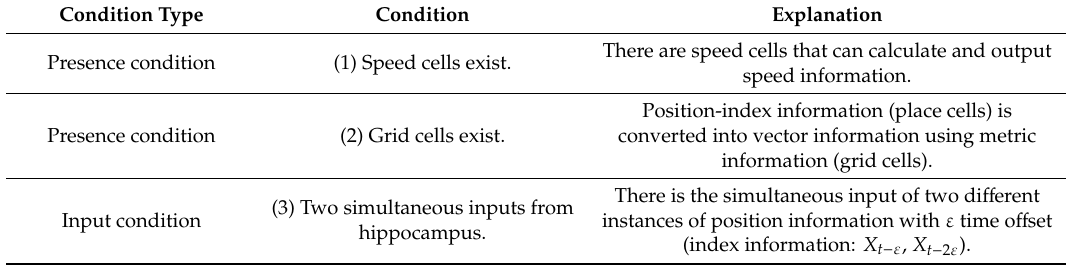
Figure 5. Prospective-speed-calculation algorithm. When two different instances of position information with ε time offset (index information: 𝑋 (cid:3047)(cid:2879)(cid:3084) , 𝑋 (cid:3047)(cid:2879)(cid:2870)(cid:3084) ) are input simultaneously, the two position vectors are obtained by converting position-index information for two adjacent instances into metric information. Prospective-speed information ( 𝑉 (cid:3047)(cid:2879)(cid:3084) (cid:3562) ) is obtained by calculating velocity vector from difference between two position vectors. Under this assumption, 𝑉 (cid:3047)(cid:2879)(cid:3084) (cid:3562) is expressed as 𝑉 (cid:3047)(cid:2878)(cid:2869) (cid:3563) because 𝑉 (cid:3047)(cid:2879)(cid:3084) (cid:3562) represents speed information to calculate next prospective position 𝑋 (cid:3047)(cid:2878)(cid:2869) (cid:3555) . Table 1. Required conditions for executing prospective-speed-calculation algorithm.